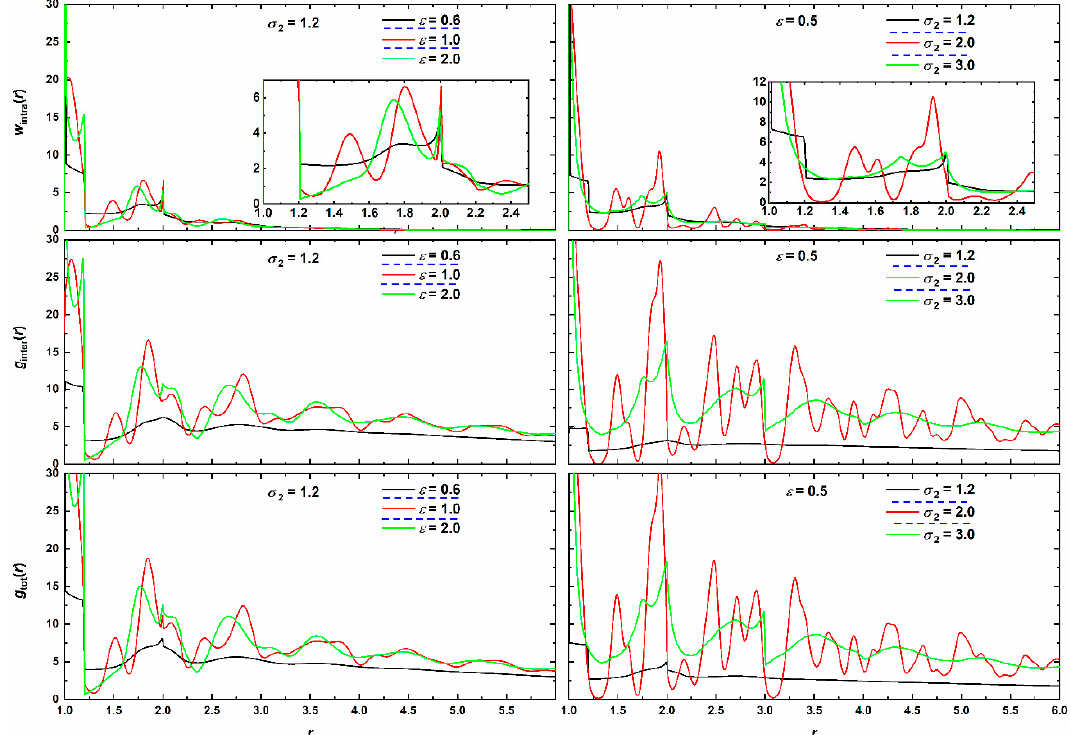
Figure 15. ( Top panels) Intramolecular density function, w intra ( r ); ( middle panels) intermolecular pair distribution function, g inter ( r ) and ( bottom panels) total pair radial distribution function, g tot ( r ) as functions of radial distance, r , for (left column) various attraction intensities, ε , for fixed range ( σ 2 = 1.2) and (right column) various attraction ranges, σ 2 , for fixed intensity ( ε = 0.5). Black, red and green correspond to SW chain clusters being amorphous, crystalline and glassy, respectively. Insets in the w intra panels correspond to zoom into short radial distances and the analogous peaks. Dashed horizontal blue lines in legend identify transitions to different phase regimes: amorphous → crystalline → glassy.